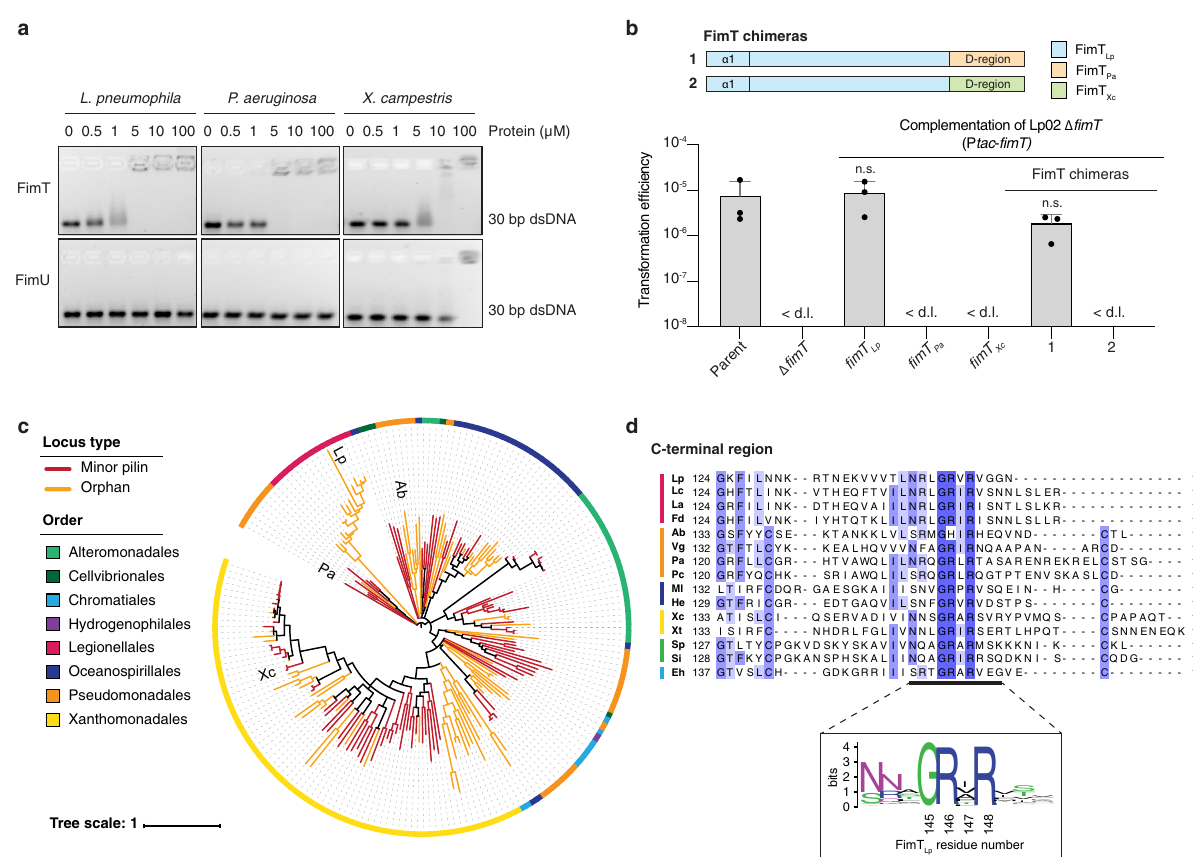
Fig. 5 Bioinformatic and functional analysis of FimT orthologues. a EMSA showing in vitro DNA binding of puri fi ed FimT and FimU orthologues from L. pneumophila , P. aeruginosa and X. campestris . A 30 bp dsDNA fragment (1 μ M) was incubated with increasing concentrations of puri fi ed pilins (0 – 100 μ M) and resolved by agarose gel electrophoresis. These experiments were independently performed three times with reproducible results. b A comparison of natural transformation ef fi ciencies of the Lp02 Δ fi mT strain complemented by ectopic expression of FimT Lp , FimT orthologues from P. aeruginosa (FimT Pa ) and X. campestris (FimT Xc ), or chimeric FimT mutants (1 – 2). The corresponding composition of these FimT chimeras (1 – 2) is explained by a schematic drawing (top). The mean transformation ef fi ciencies of three independent biological replicates are shown with error bars representing the SD. < d.l., below detection limit (d.l.) (average d.l. = 4.8 × 10 − 8 ± 2.1 × 10 − 8 ). An unpaired two-sided t-test with Welch ’ s correction, using log-transformed data, was used to analyse statistical signi fi cance. The Lp02 Δ fi mT strain complemented with the chimeric construct was compared to the Lp02 Δ fi mT strain complemented with wild-type FimT, which was in turn compared to the parental strain. n.s., not statistically signi fi cant, p > 0.05 ( p fi mTLp = 0.69; p 1 = 0.1). c Phylogenetic tree of FimT homologues, comprising eight orders of γ -Proteobacteria illustrated by the coloured circumferential ring. Branches coloured in orange represent FimTs encoded as orphan genes, whereas those coloured red represent FimTs encoded within minor pilin operons. The positions of the four functionally characterised FimT orthologues in the tree are indicated (Lp, L. pneumophila ; Ab, A. baylyi ; Pa, P. aeruginosa ; and Xc, X. campestris ). The scale bar indicates the average number of substitutions per site. d Top, multisequence alignment of representative FimT orthologues across six orders (indicated by a coloured line as in c) focusing on their C-terminal region (Lc, Legionella cherrii ; La, Legionella anisa ; Fd, Fluoribacter dumof fi i ; Vg, Ventosimonas gracilis ; Pc, Pseudomonas chloritidismutans ; Ml, Marinicella litoralis ; He, Halomonas endophytica ; Xt, Xylella taiwanensis ; Sp, Shewanella polaris ; Si, Shewanella indica ; Eh, Ectothiorhodospira haloalkaliphile ). Residues are coloured according to sequence identity. Bottom, sequence logo generated from the full